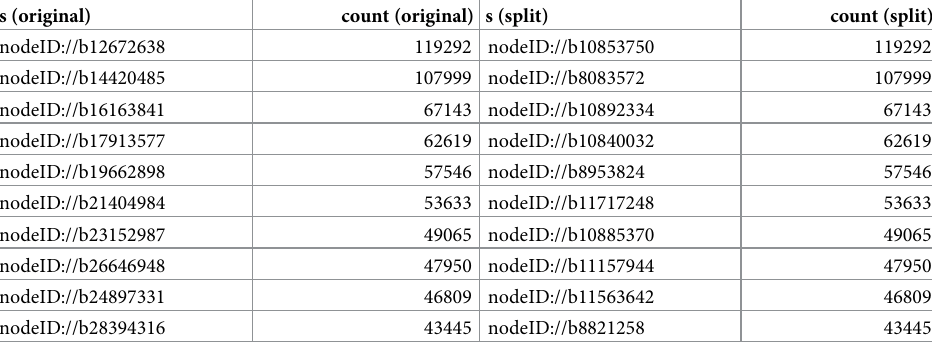
Table 2. The top ten rows of the results using Query1 for Allie